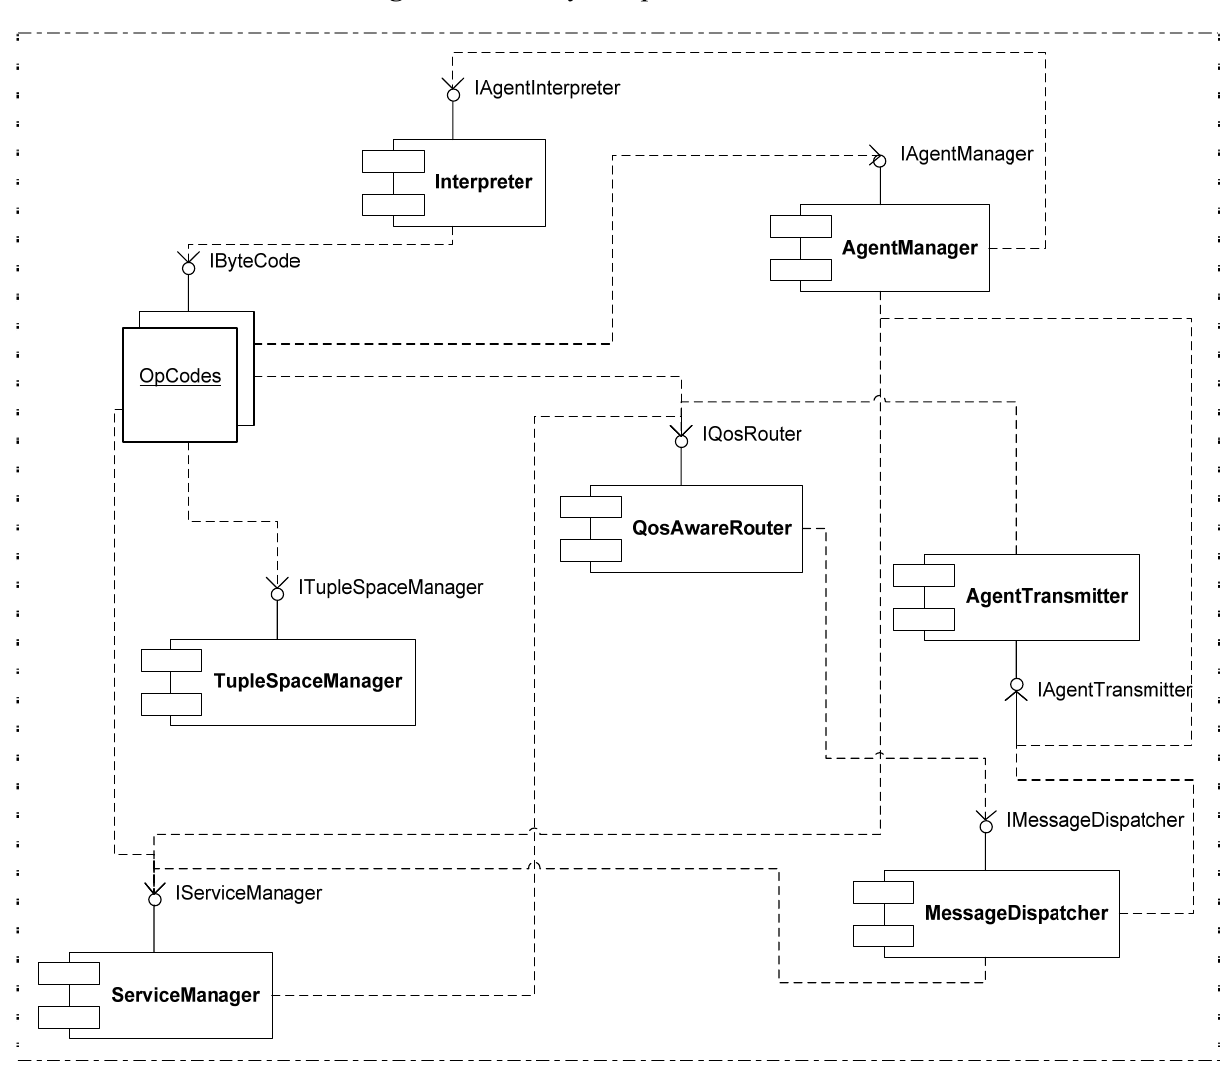
Figure 9. The key components of